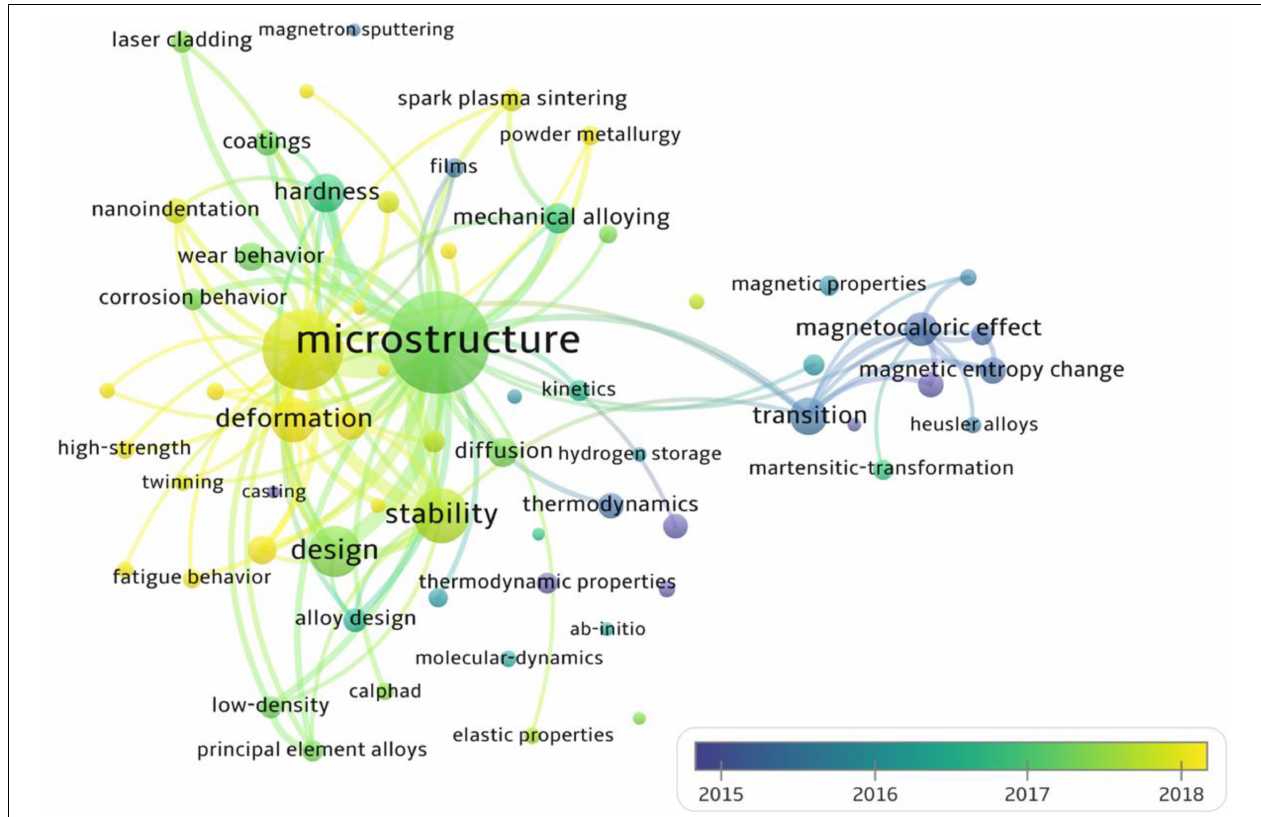
FIGURE 8 | The changes of research keywords with the average time, reflecting the future development directions of HEAs. The search keyword is the “high entropy alloys,” and the total number of article analyses is 5000 from 2004 to 2020 in the Web of Science.